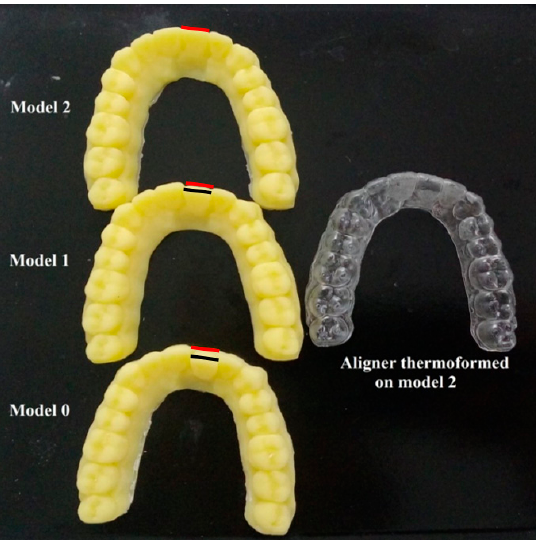
Figure 2. 3D printed models with different mal ‐ alignment of central incisor and a thermoformed aligner of ClearX material.